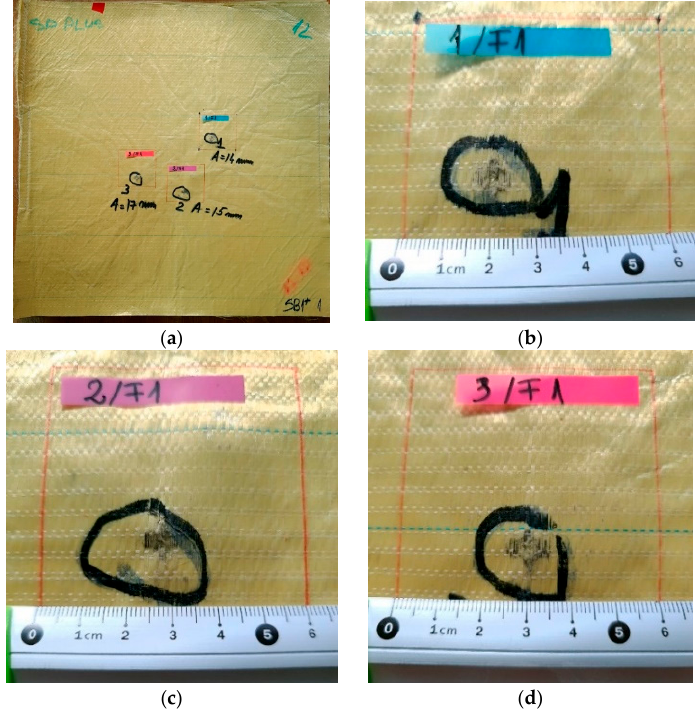
Figure 7. Frontal view ( a ) of a 12-layer LFT SB1plus package: ( a ) layer 1 (face) and details of the fires on the first layer of the package: ( b ) fire 1, ( c ) fire 2 and ( d ) fire 3. BFS was noted as A on the photo.